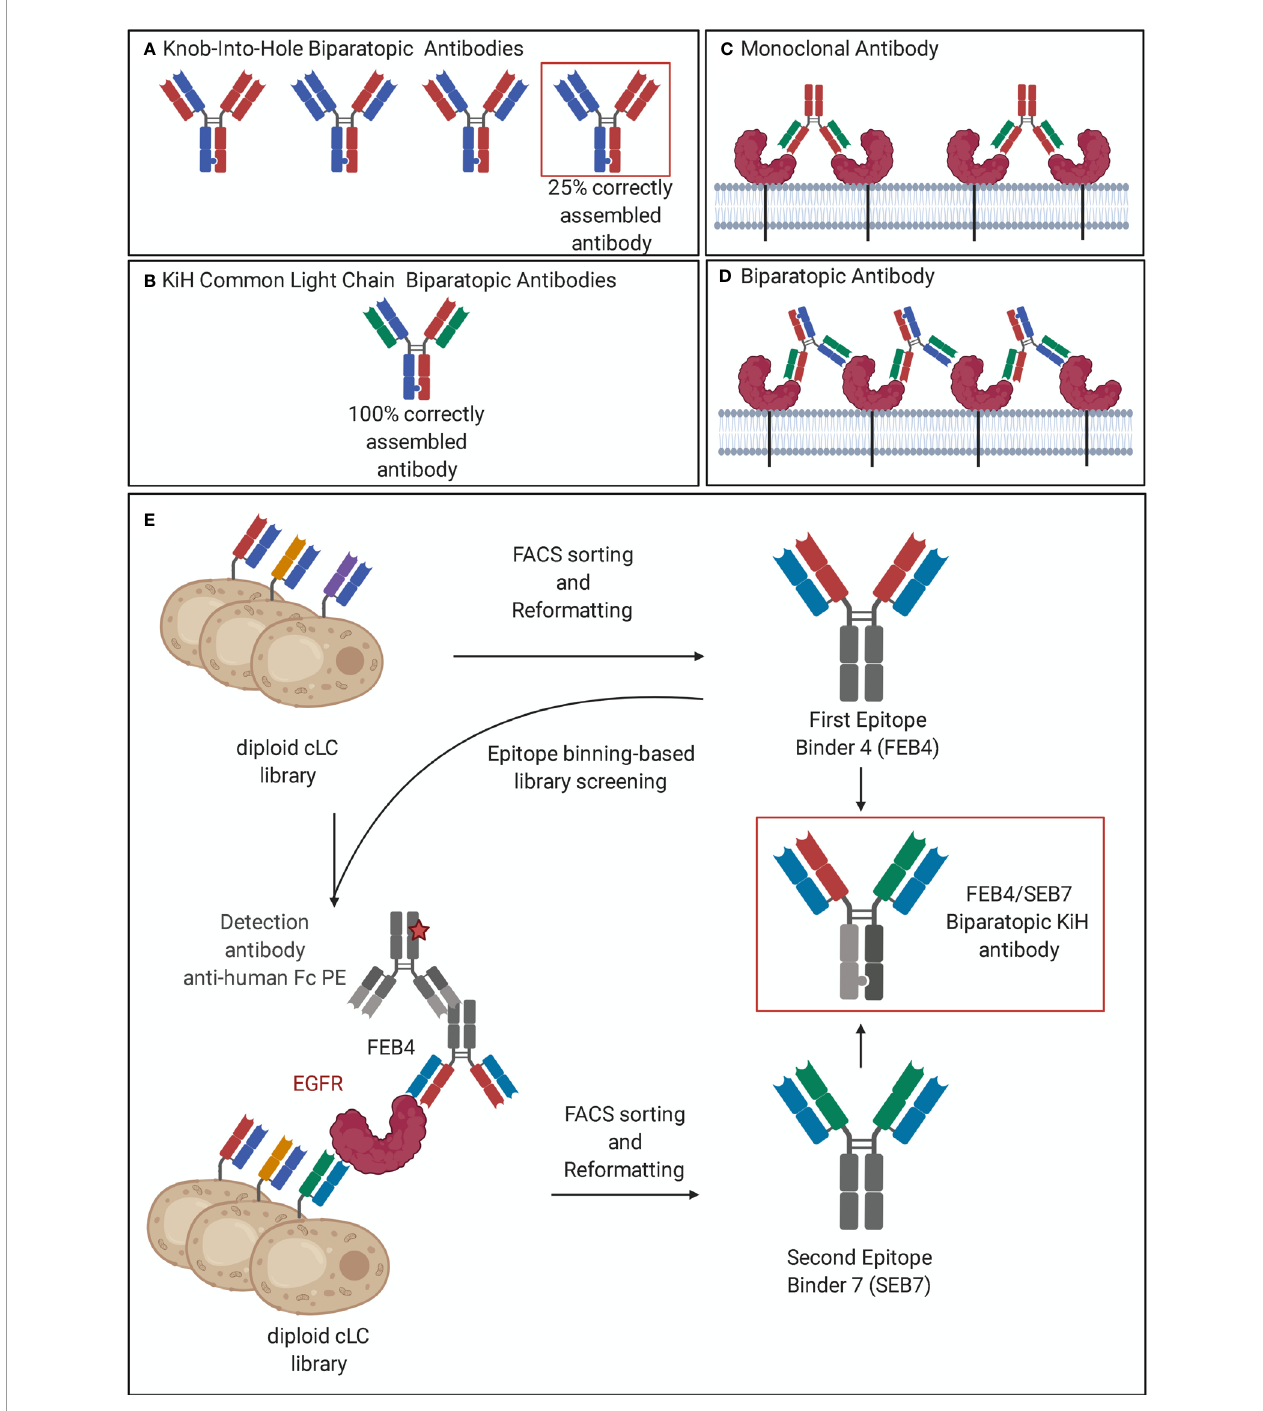
FIGURE 1 | Common light chain biparatopic antibodies and schematic representation of the screening procedure. (A) The heterodimerization of the heavy chains is achieved by the Knob-into-Hole technology. Due to the need for correct pairing of heavy and light chains, only 25% of produced antibodies are correctly assembled. (B) The utilization of a common light chain pairing with both heavy chains enabled the circumvention of the light chain pairing problem. (C) Monoclonal antibodies recognize a single epitope of the target antigen and can therefore bind to two individual receptors. (D) Biparatopic antibodies bind to two distinct epitopes of the same antigen. By binding to two receptor molecules, additional epitopes on the target remain exposed allowing for the binding of an additional antibody, leading to crosslinking of the target receptor and receptor clustering. (E) Epitope binning-based FACS screening resulted in two VH domains, addressing orthogonal epitopes while comprising one common light chain. Subsequent reformatting into the Knob-into-Hole format enabled the production of a biparatopic antibody. Created with